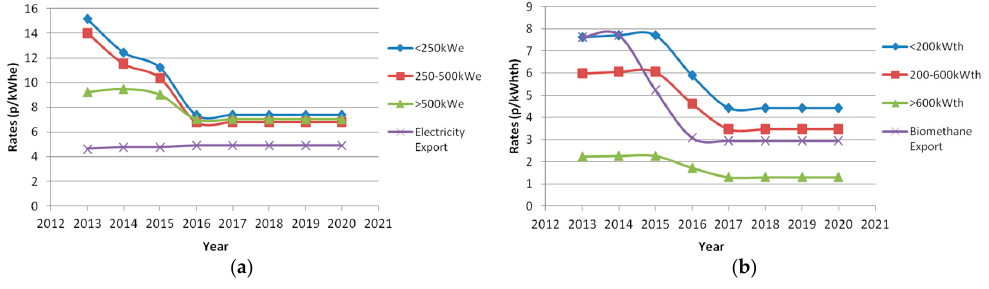
Figure 2. ( a ) Feed-in tariff (FiT) and ( b ) renewable heat incentive (RHI) rates trend for